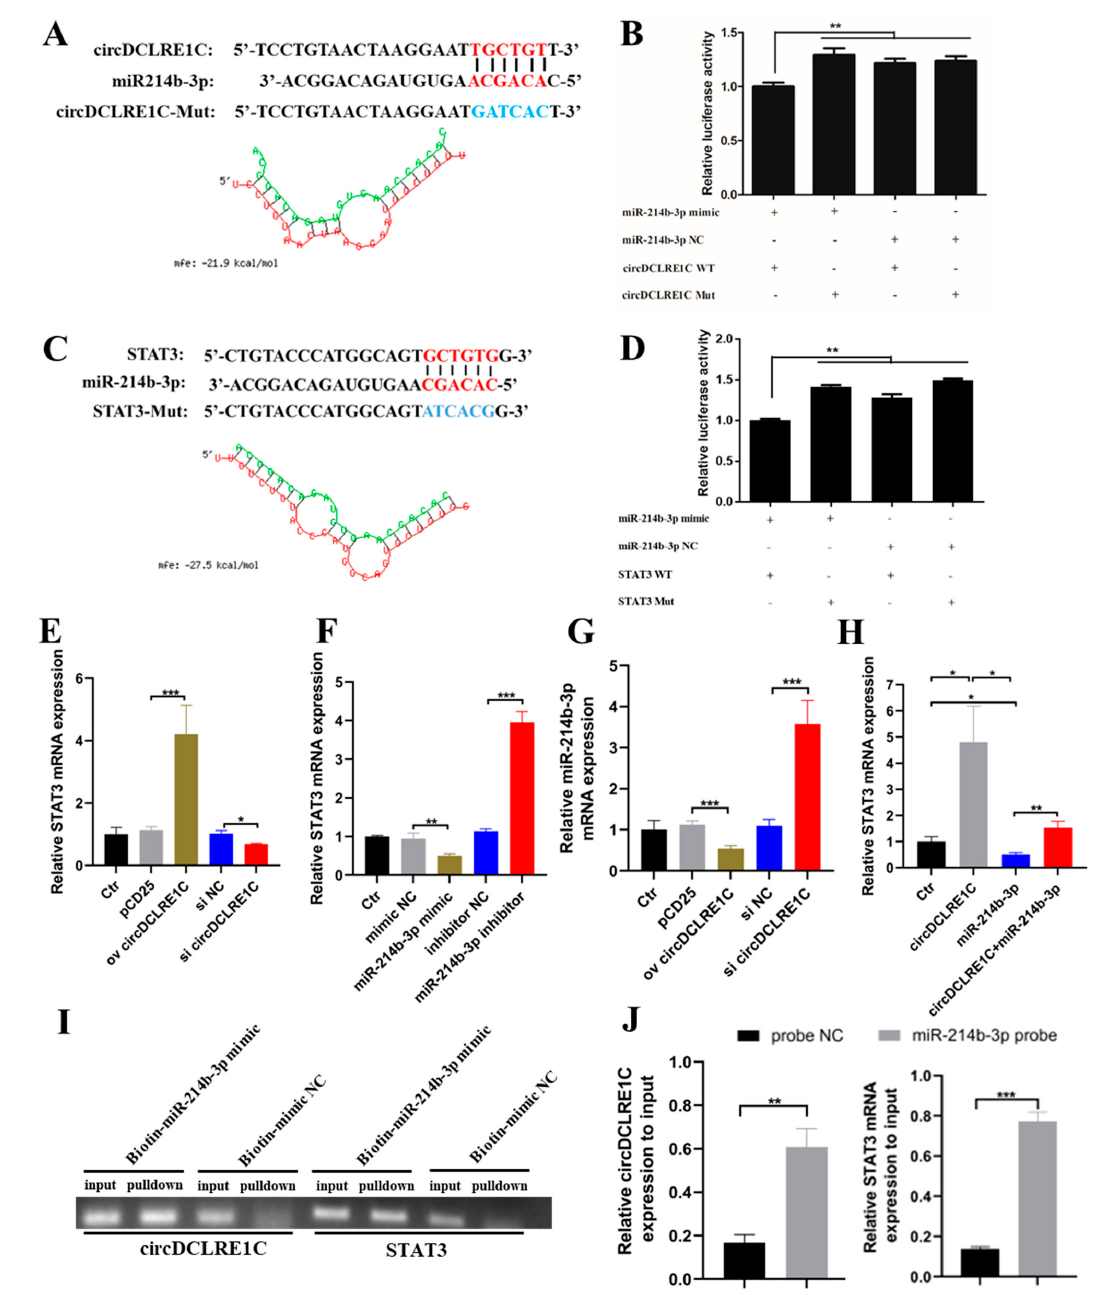
Figure 3. CircDCLRE1C could serve as a sponge for miR-214b-3p to regulate the expression of STAT3: ( A , C ) The potential binding site sequence (highlighted in red) of miR-214b-3p on circDCLRE1C or STAT3, and the model of interaction between miR-214b-3p and circDCLRE1C or STAT3, modeled by RNAhybrid software. ( B , D ) Dual-luciferase assay verifying the binding relationship between miR-214b-3p and circDCLRE1C or STAT3, respectively. ( E ) The mRNA level of STAT3 in HD11 cells with circDCLRE1C overexpression and knockdown, as measured by qRT-PCR. ( F ) The mRNA level of STAT3 in HD11 cells with miR-214b-3p mimics and inhibitors. ( G ) The mRNA level of miR-214b-3p in HD11 cells with circDCLRE1C overexpression and knockdown. ( H ) The increased expression of STAT3 in HD11 cells with circDCLRE1C overexpression could be rescued by mi- 214b-3p. ( I , J ) CircDCLRE1C was pulled down by the biotin-miR-214b-3p probe, as detected by gel electrophoresis and qRT-PCR. The relative levels were normalized to the input. Data are presented as means ± SD ( n = 3 biologically independent samples). * p < 0.05; ** p < 0.01; *** p < 0.001 (Student’s t